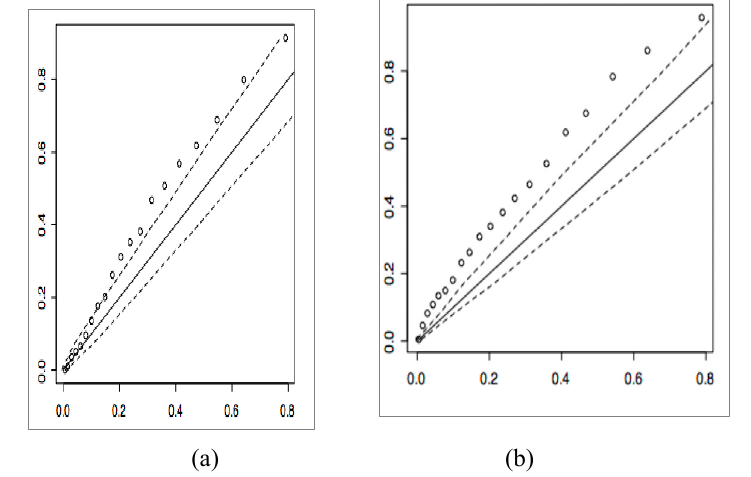
Figure 6. Comparative test Tau -plots using a 95% confidence level. (a) Dependence between intensities fitted by Independence copula. (b) Dependence between fundamental frequencies fitted by Independence copula.